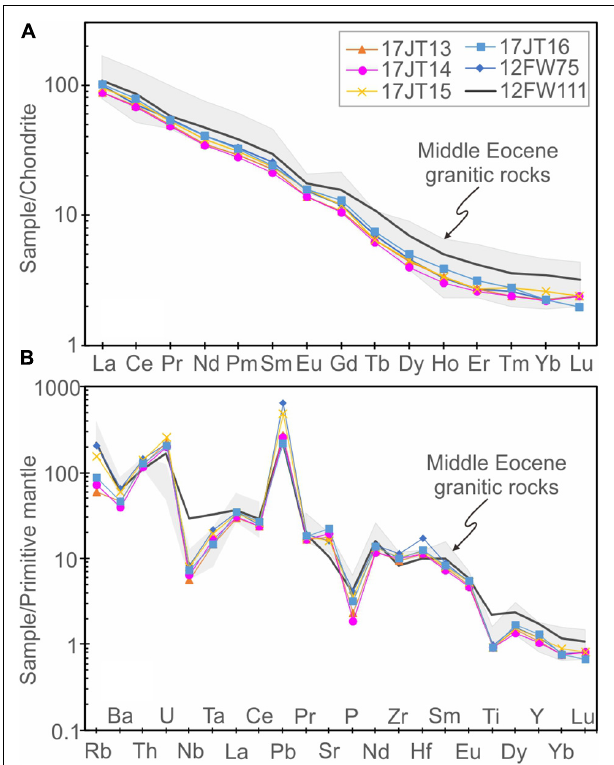
FIGURE 6 | Chondrite-normalized REE variation diagram (A) and primitive mantle-normalized spider diagrams (B) for samples of this study. The normalization data are from Sun and McDonough (1989). Data sources: middle Eocene granitic rocks: Zeng et al. (2011) and Hou et al. (2012); Ramba Eocene dike (12FW111): Liu et al.